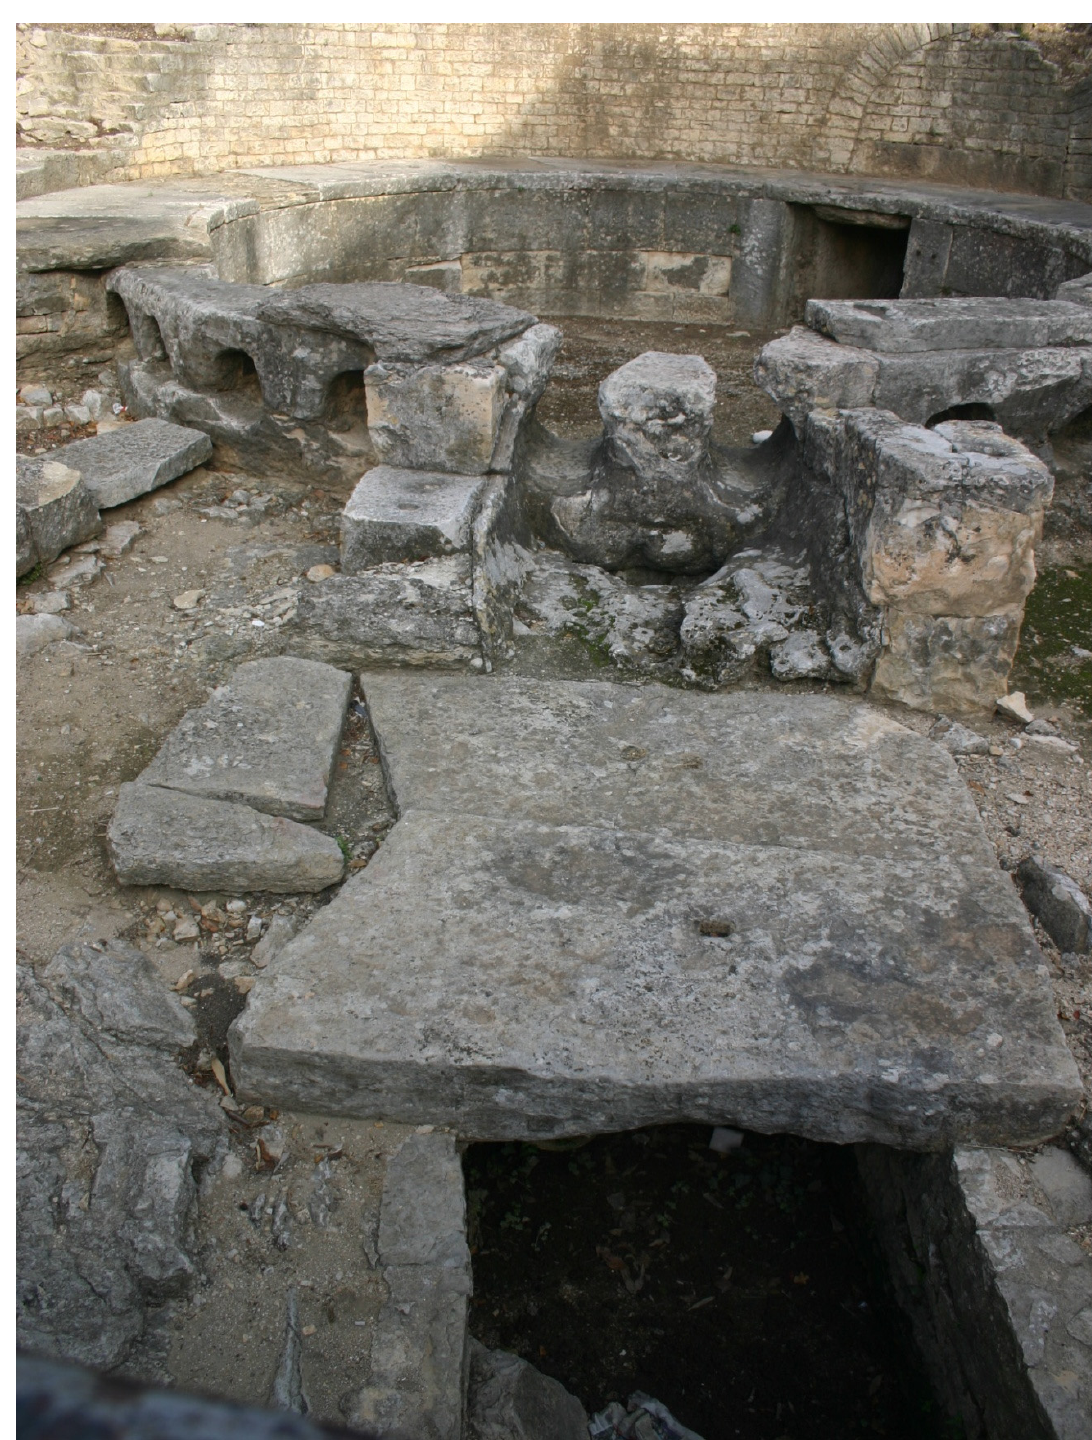
Figure 5. View of structures in front of the Nîmes castellum .